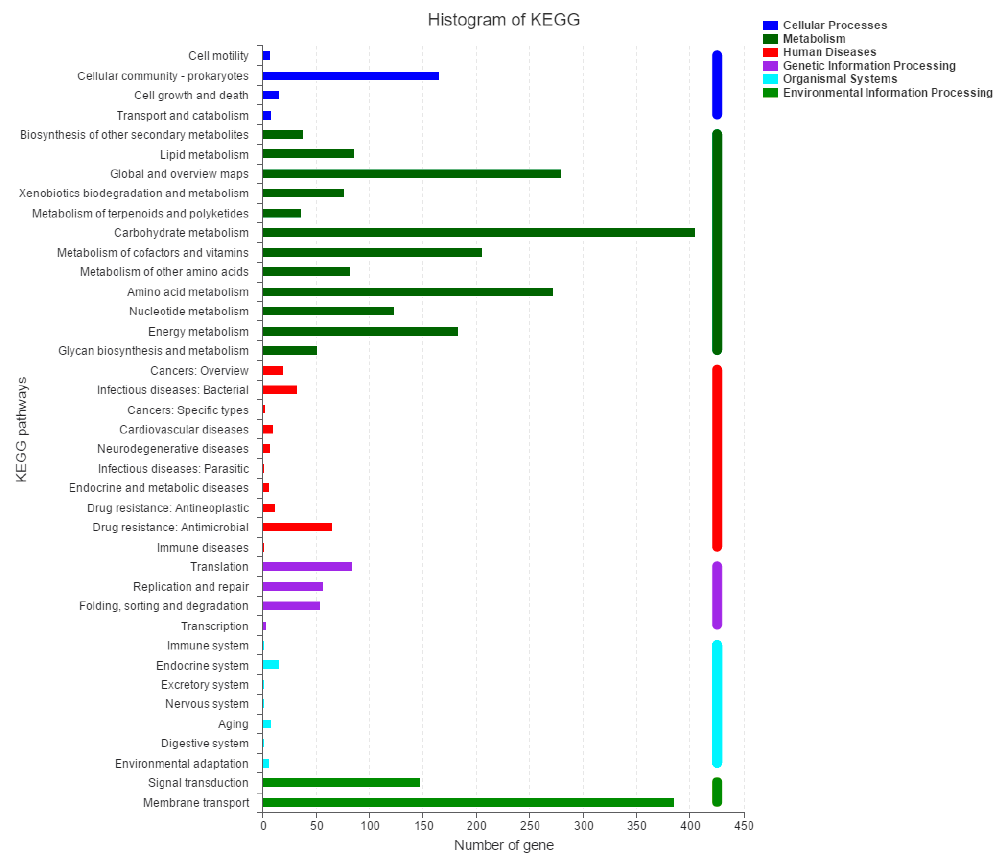
Figure 4. Categories of metabolic pathways of genes from K. pneumoniae 2N3 based on the Kyoto Encyclopedia of Genes and Genomes (KEGG) database.